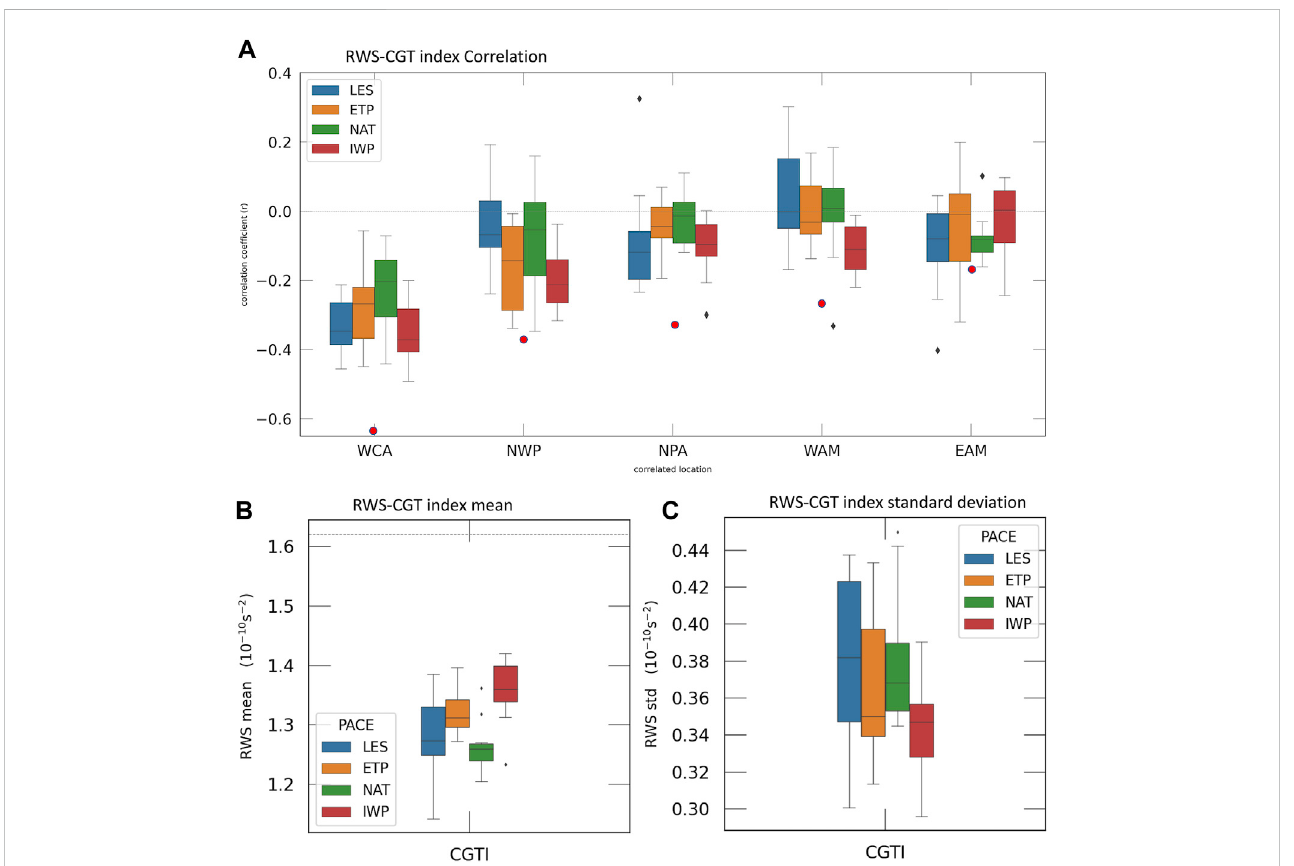
FIGURE 3 (A) The boxplot of 10-ensemble members correlation coef fi cient between RWS_CGT index (red box in Figures 2A – E) and Z200 at observed centers of CGT pattern (purple boxes in Figures 2F – J) for each pacemaker. Red dots show the correlation coef fi cients from the observed data. (B) The boxplot of 10- ensemble summertime RWS mean, and the dashed line shows the RWS mean of observation. (C) The boxplot of 10-ensemble summertime RWS standard deviation. The locations of RWS_CGT is at 50 ° E – 70 ° E and 30 ° N – 45 ° N. The centers of CGT pattern are at West-central Asia (WCA; 60 ° E – 75 ° E